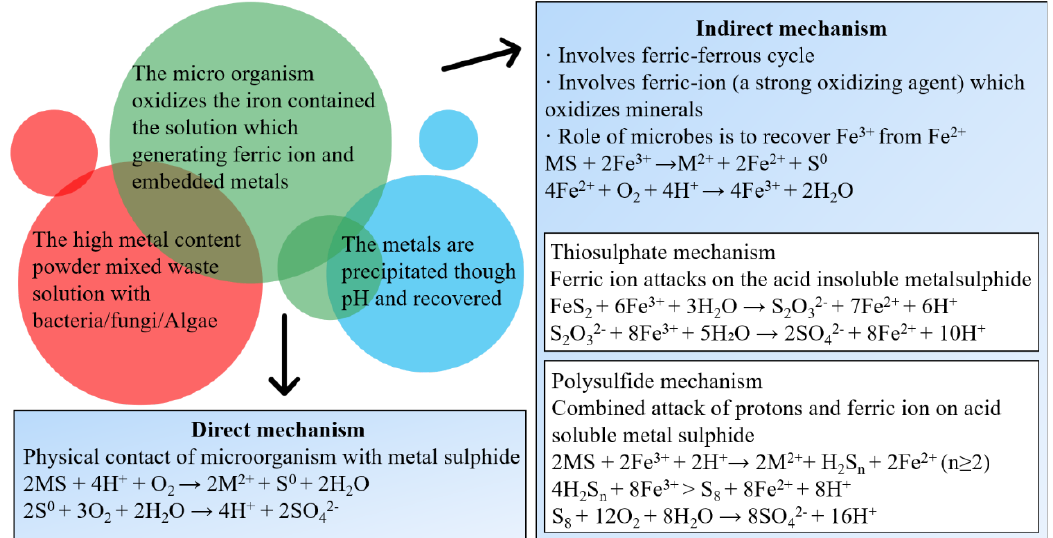
Figure 2. Bioleaching mechanisms of metals from WPCBs [25].